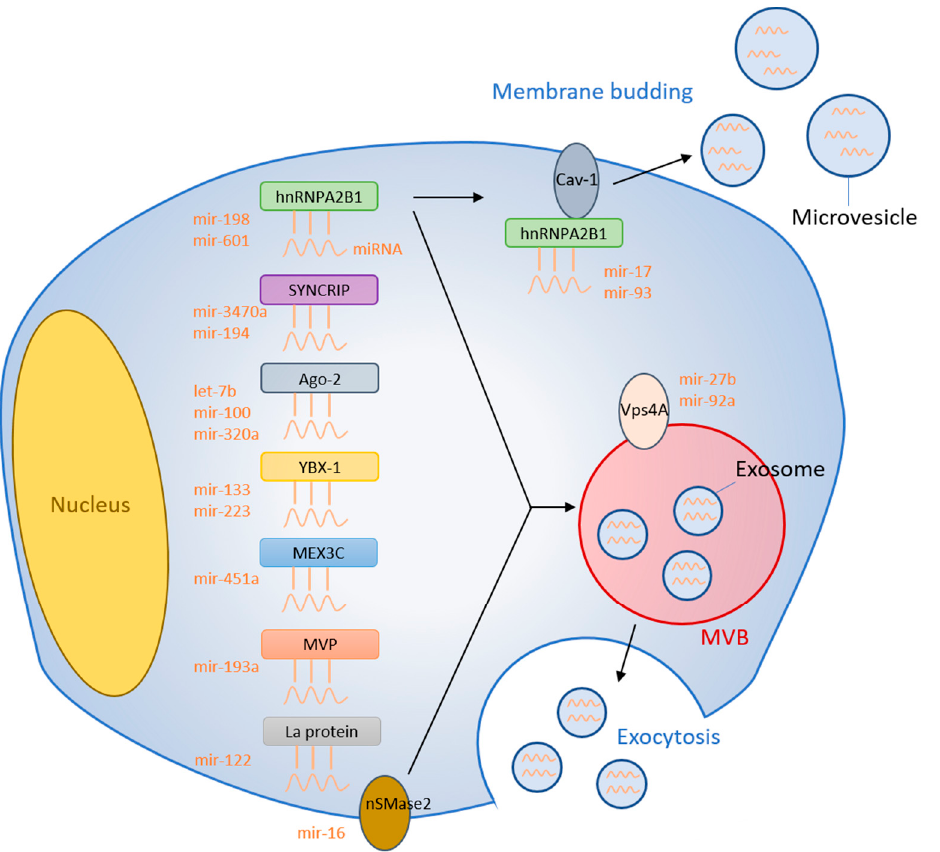
Figure 1. Summary of miRNA sorting into EVs. RNA binding proteins bind specific miRNAs and selectively shuttle them into EVs. Membranous proteins are also involved in the miRNA sorting mechanism.